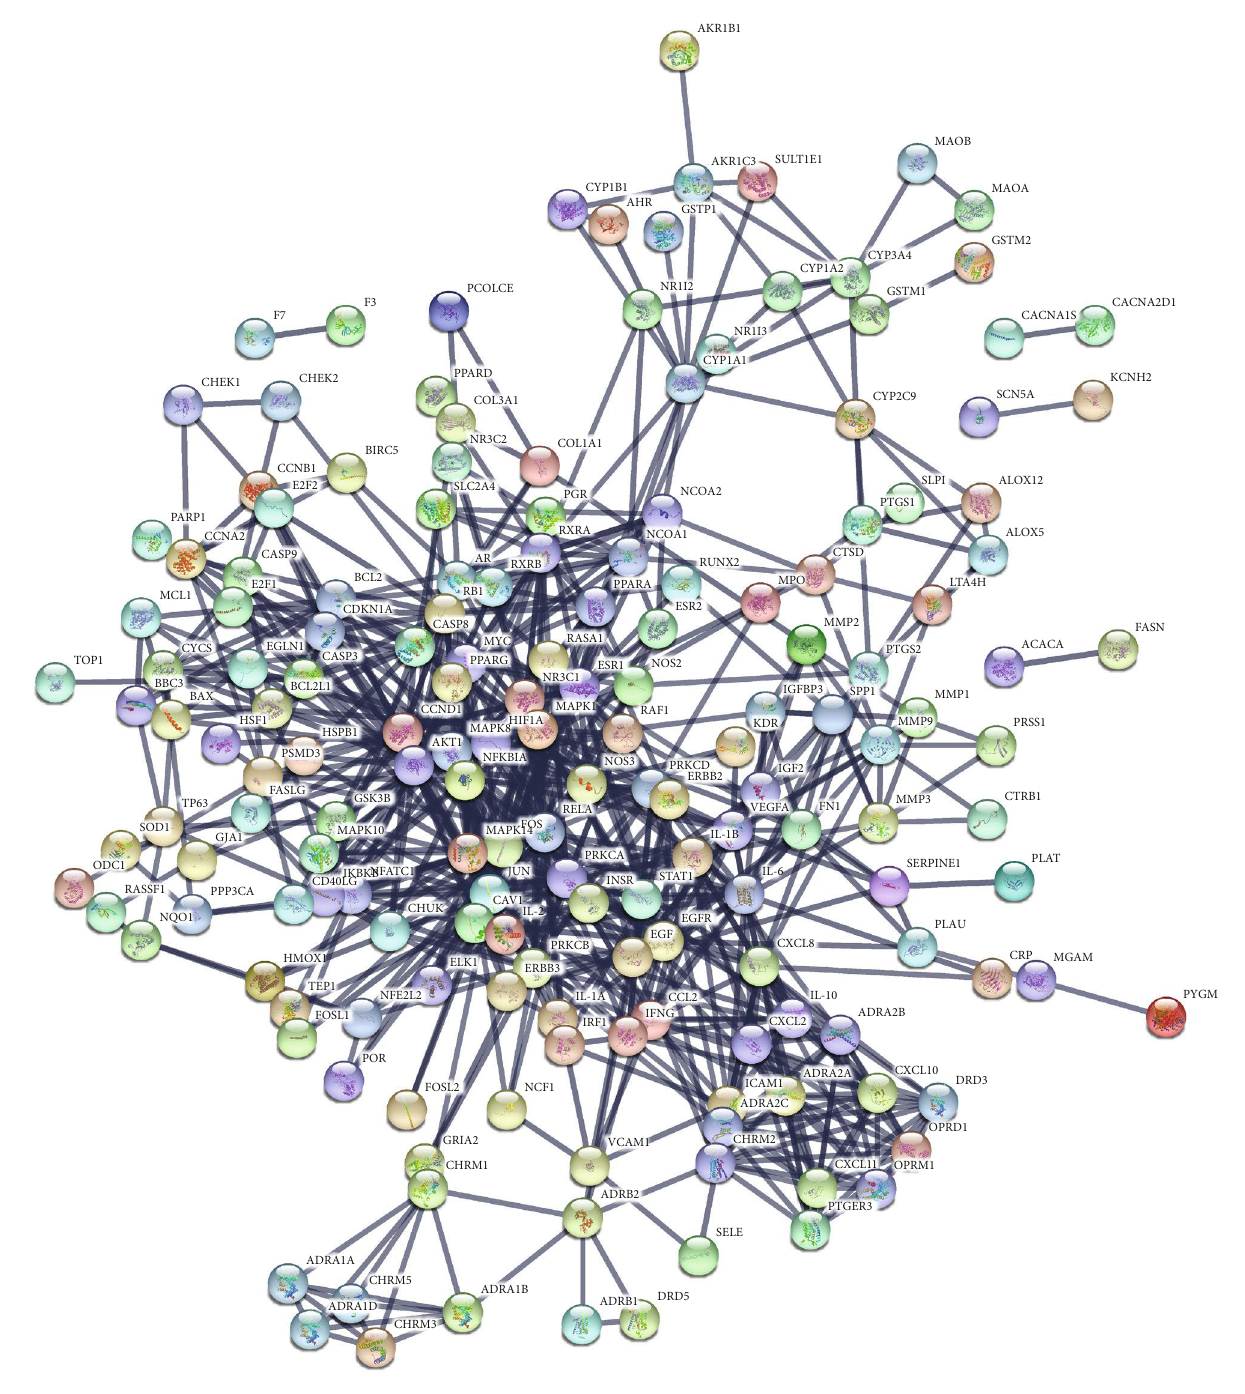
Figure 4: PPI network of targets for HLJDD against